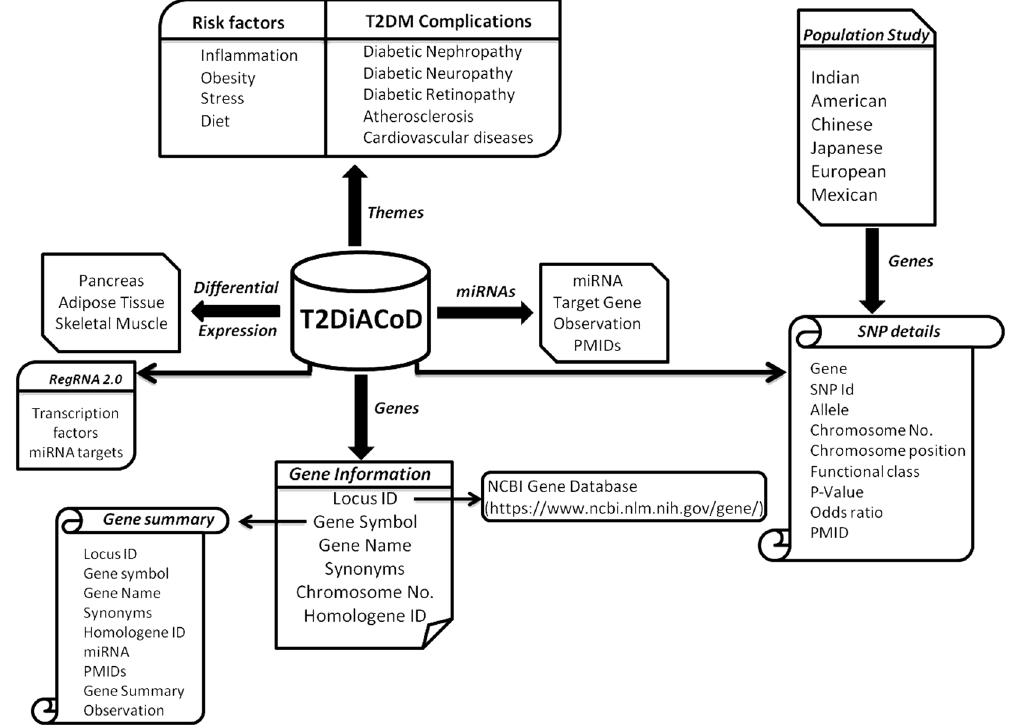
Figure 4. Database structure. T2DiACoD is a tetrapodic layout (i) T2DM associated complications, (ii) Gene expression (iii) miRNA for T2DM (iv) Population studies.